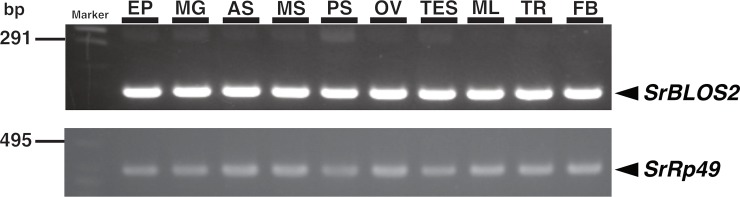
RT-PCR analysis of Samia ricini biogenesis of lysosome-related organelles complex 1, subunit 2 (SrBLOS2) in S. ricini larval tissues.Total RNA of fifth-instar day 4 larvae of the wild-type individuals was used for RT-PCR. SrRp49 was used as an internal control. EP, epidermis; MG, midgut; AS, anterior silk gland; MS, middle silk gland; PS, posterior silk gland; OV, ovary; TES, testis; ML, Malpighian tubule; TR, trachea; FB, fat body.